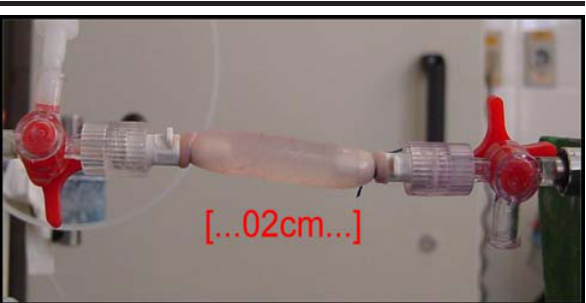
FIGURE 6 - Detail of the loop ready for the rupture test